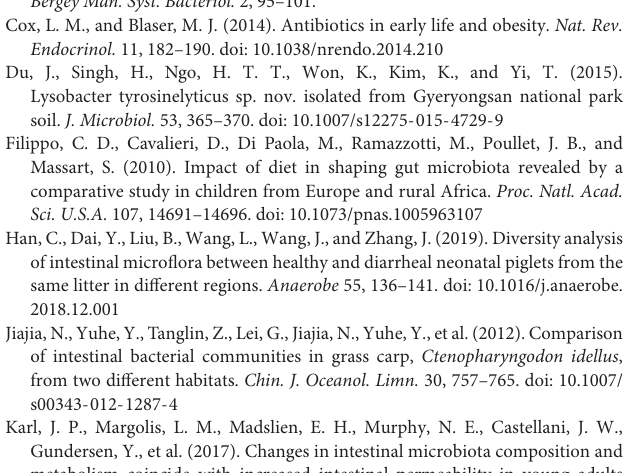
FIGURE S1 | Rarefaction curve for all samples. FIGURE S2 | Circos Diagram between the MM group and the FM group on phylum level. FIGURE S3 | PLS-DA scores plot derived from the MM group and the FM group. FIGURE S4 | Species difference analysis of the MM group and the FM group at phylum level. FIGURE S5 | Species difference analysis of the MM group and the FM group at genus level. FIGURE S6 | The unique Species derived from the FM group at the species level ( > 1%). FIGURE S7 | The unique Species derived from the MM group at the species level ( > 1%). FIGURE S8 | LEfSe map of species differences between the FM group and MM group at the species level (highly significant bacteria with LDA score > 2). TABLE S1 | Formulation of the experimental diets (% dry weight). a These materials were provided by JiangXi for Farmer Bio-Tech Co. Ltd. (Nanchang, Jiangxi, China). b Premix (in per kg diet): VA 5,000 IU, VB 1 25 mg, VB 2 45 mg, VB 6 20 mg, VB 12 0.1 mg, VK 3 10 mg, VE 200 mg, VC 200 mg, VD 3 2,500 IU,